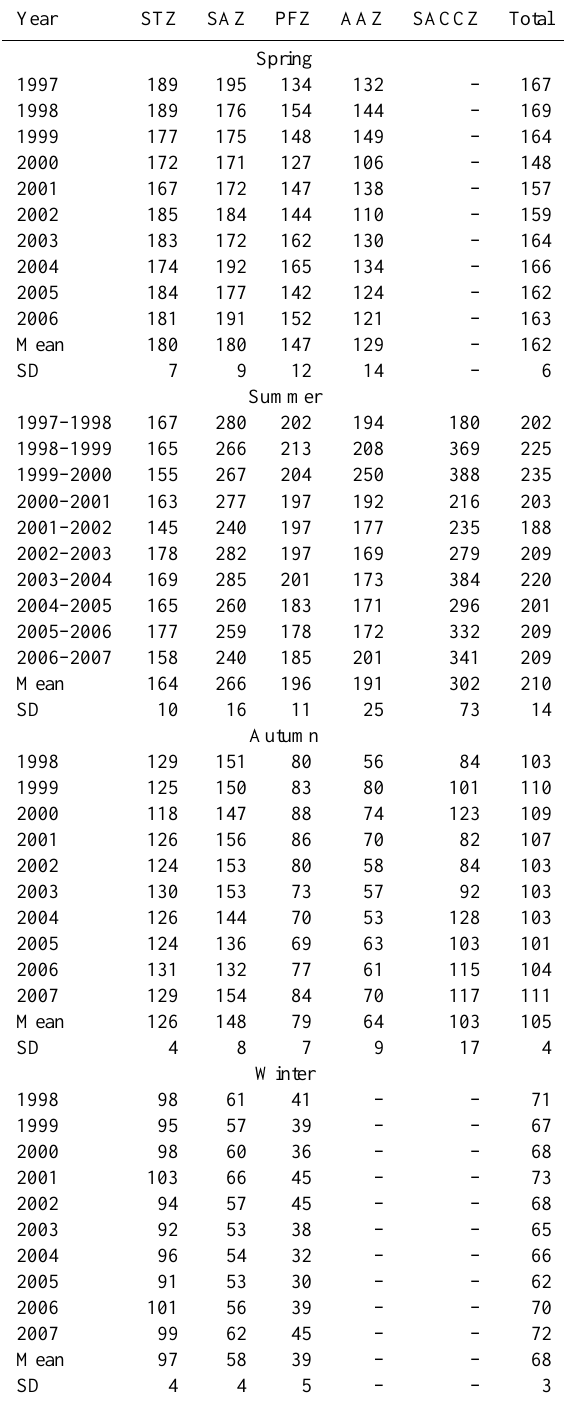
Table 2. Inter-annual variations in seasonal mean NPP (mg